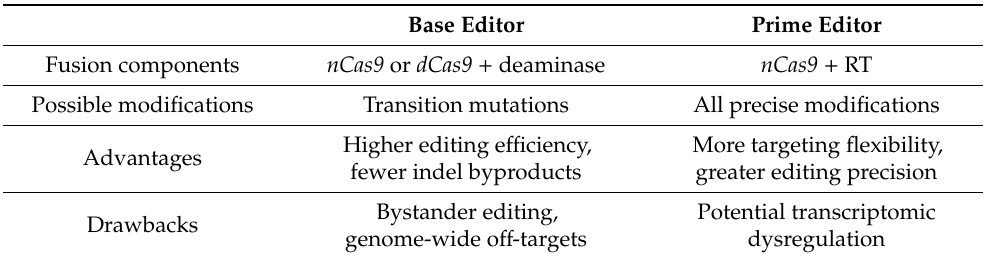
Table 1. Comparison of clustered regularly interspaced short palindromic repeat (CRISPR) genome-editing systems using base editor and prime